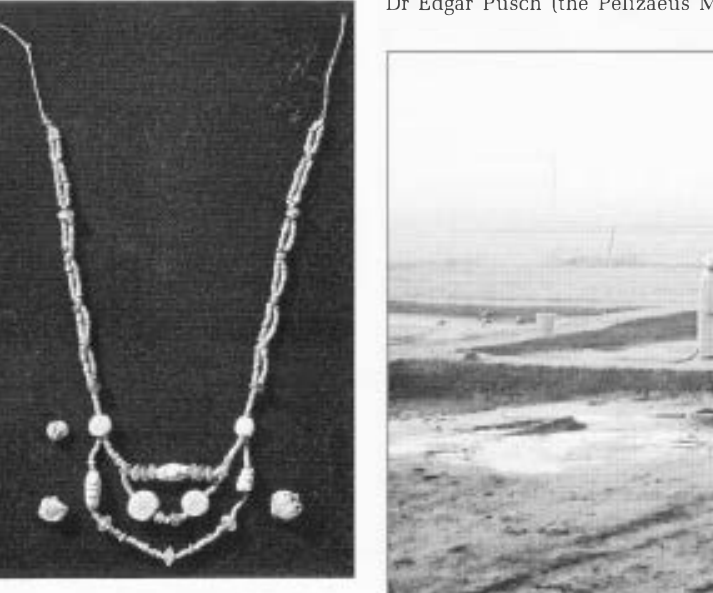
Figure 1 A necklace made from glass, faience and Egyptian blue. Figure 2 The shallow water table at